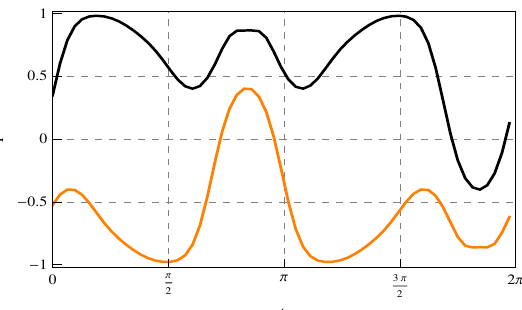
Figure 6. Spin polarization co-efficient P as a function of φ ν at two typical energies, where the orange and black curves are for E = − 0.75eV and E = 0.75eV, respectively. Here, we consider A x = 0.75 and θ i = 0 ∀ i .